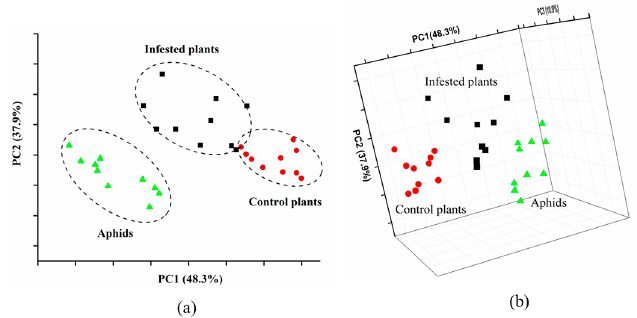
Figure 6. 2D-PCA plot ( a ) and 3D-PCA plot ( b ) of healthy plants, aphid-infested plants, and Figure 6. 2D - PCA plot ( a ) and 3D-PCA plot ( b ) of healthy plants, aphid-infested plants, and aphids. Figure 6. 2D - PCA plot ( a ) and 3D-PCA plot ( b ) of healthy plants, aphid-infested plants, and aphids. Figure 6. 2D - PCA plot ( a ) and 3D-PCA plot ( b ) of healthy plants, aphid-infested plants, and aphids.